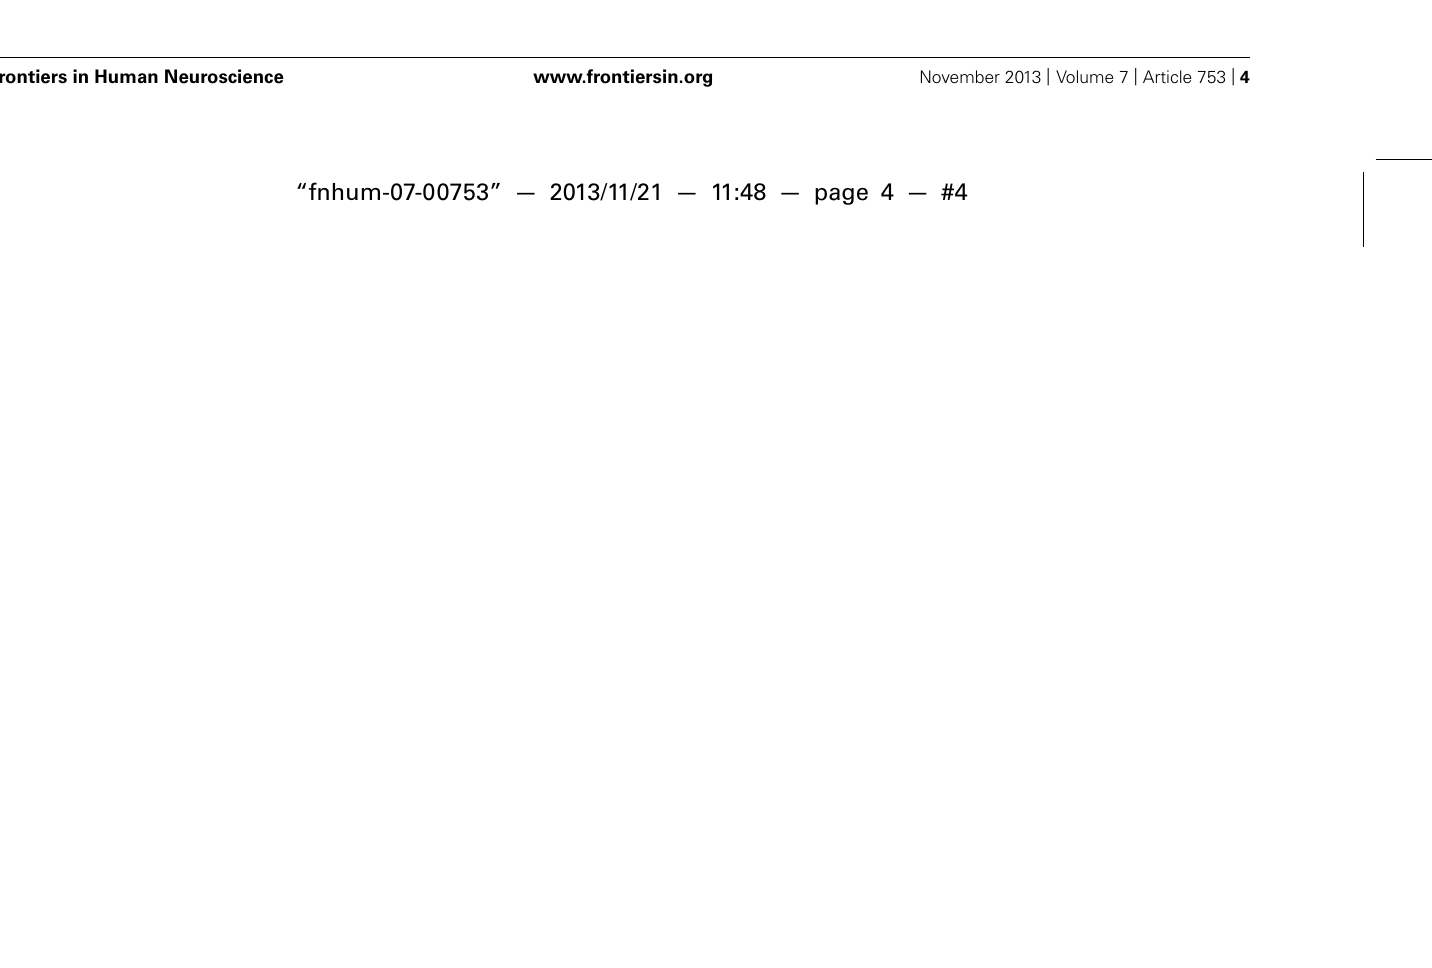
FIGURE 1 | Mean response times of lexical decision to two mixed and pure pseudohomophones and their respective controls. ∗ p <